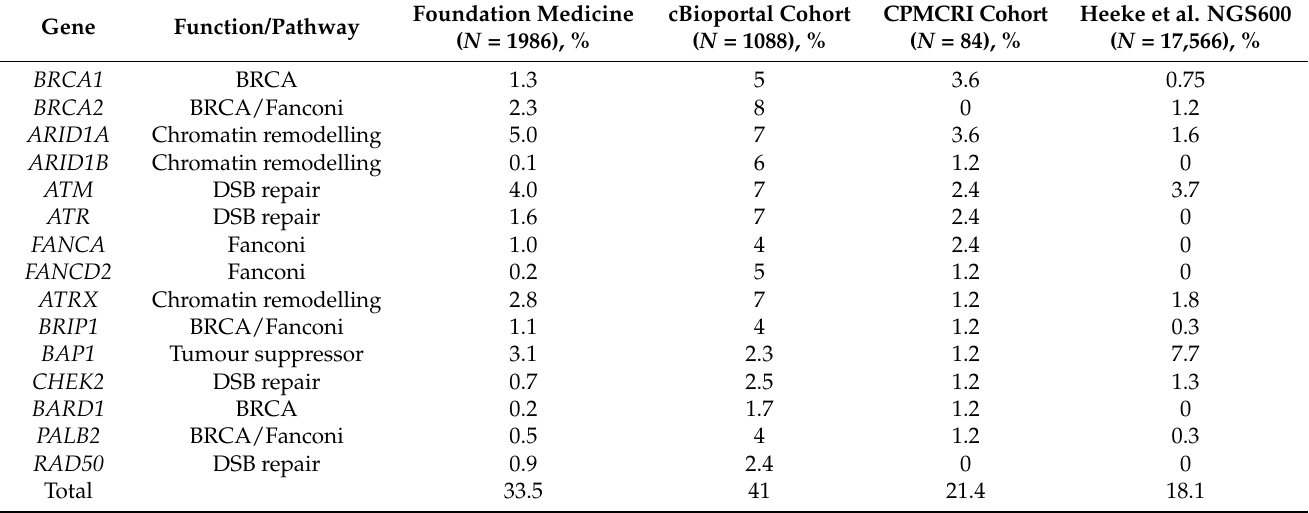
Table 1. Frequency of most commonly altered HR-DDR Gene Mutations in